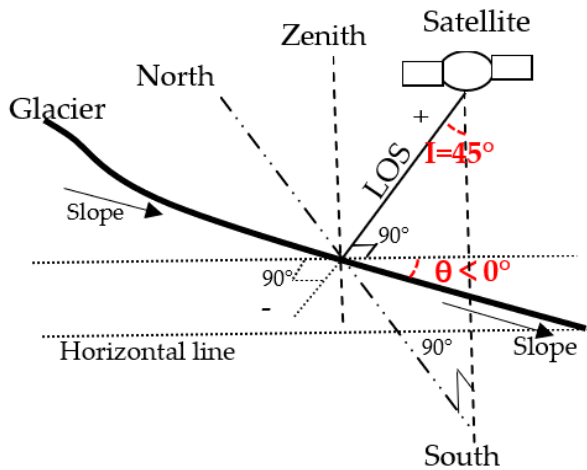
Figure 2. The relative positions of the Line of Sight (LOS), zenith, slope direction, and horizontal line for the profile of the glacier central line. The symbols “ + ” and “ − ” refer to positive and negative deformation, respectively. “I” means incidence angle, “ θ ” means the angle between slope direction and the horizontal line.